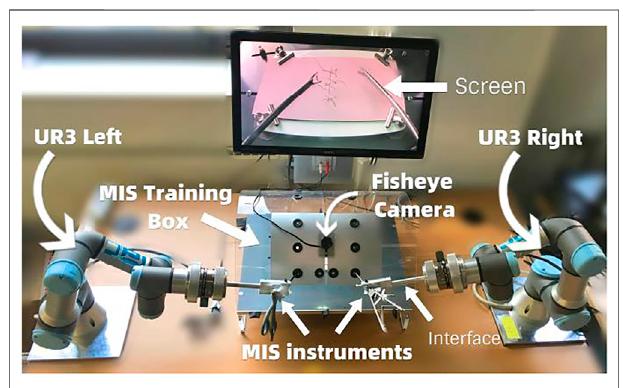
Frontiers in Robotics and AI |